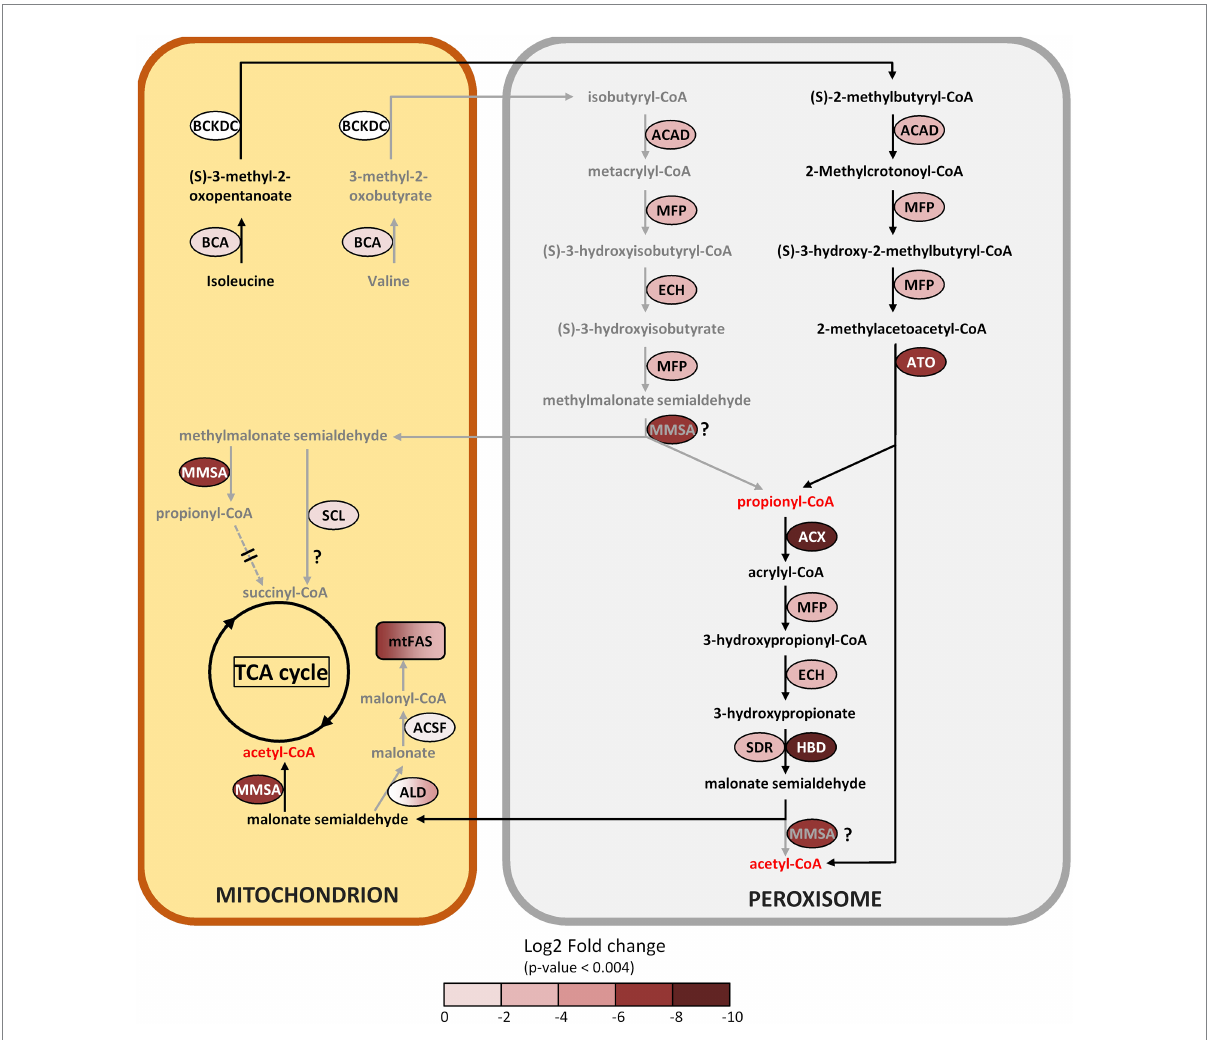
FIGURE 7 Metabolic reconstruction of the branched amino acid degradation pathway in the peroxisome and proposed interactions with the mitochondria. The log2 FC acetate/butyrate is indicated by the color codes. Further information can be found in Table 1. Arrows in grey represent less likely or hypothetical pathways, pathways that are proposed use black arrows. ACSF exhibits an FC value with p > 0.004. ALD color gradient indicates different isoforms with FC values between 0 and